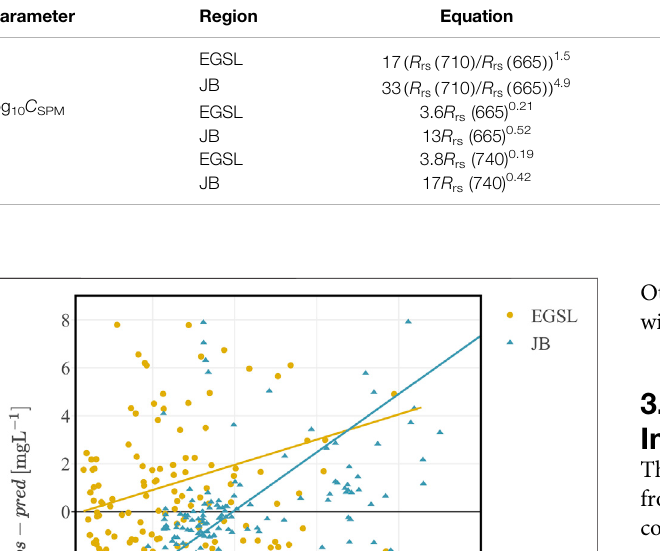
TABLE 2 | Regional algorithms for C SPM with their associated performance metrics. Numbers in bold font highlight the best model. Parameter